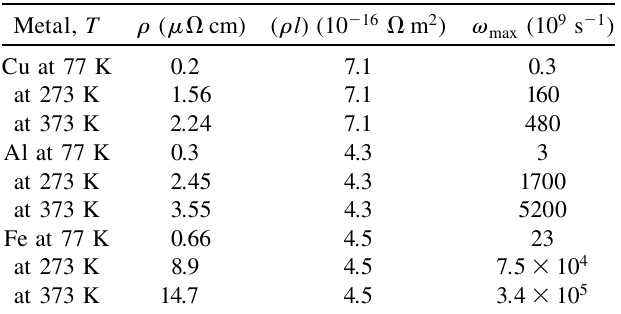
TABLE II. Resistivity, product ( $l ) [11], and implied fre- quency limits where the anomalous skin effect becomes im- portant, for three metals and temperatures.